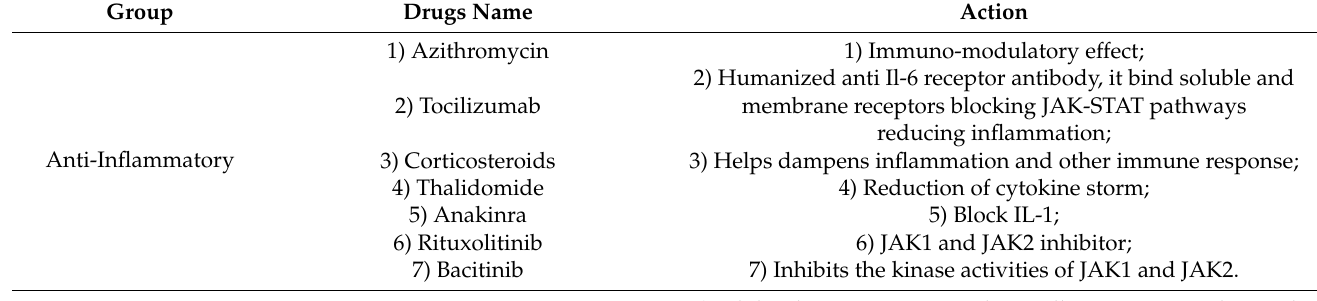
Table 3. Principal class of repurposed drugs involved into treatment of